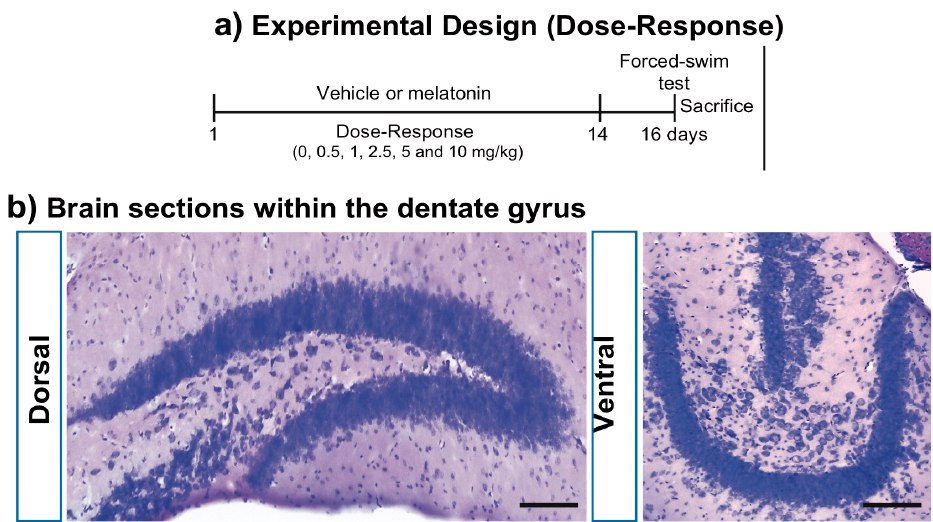
Figure 1. Administration of melatonin. ( a ) Male Balb/C male mice were kept under normal housing conditions until the age of 8 weeks. Mice were treated with vehicle (CTL) or with different doses of melatonin for 14 days. All doses of melatonin were injected at 19:00 hours. The behavioral test was performed 36 hours after the last drug administration (Day 16). n = 9–10 per group. Once behavior was assayed, mice were sacrificed to perform doublecortin analysis in both coronal and transversal sections within the dentate gyrus. Representative images after Nissl staining are shown in ( b ). Scale bars represent 100 μ m. n = 6 per group.